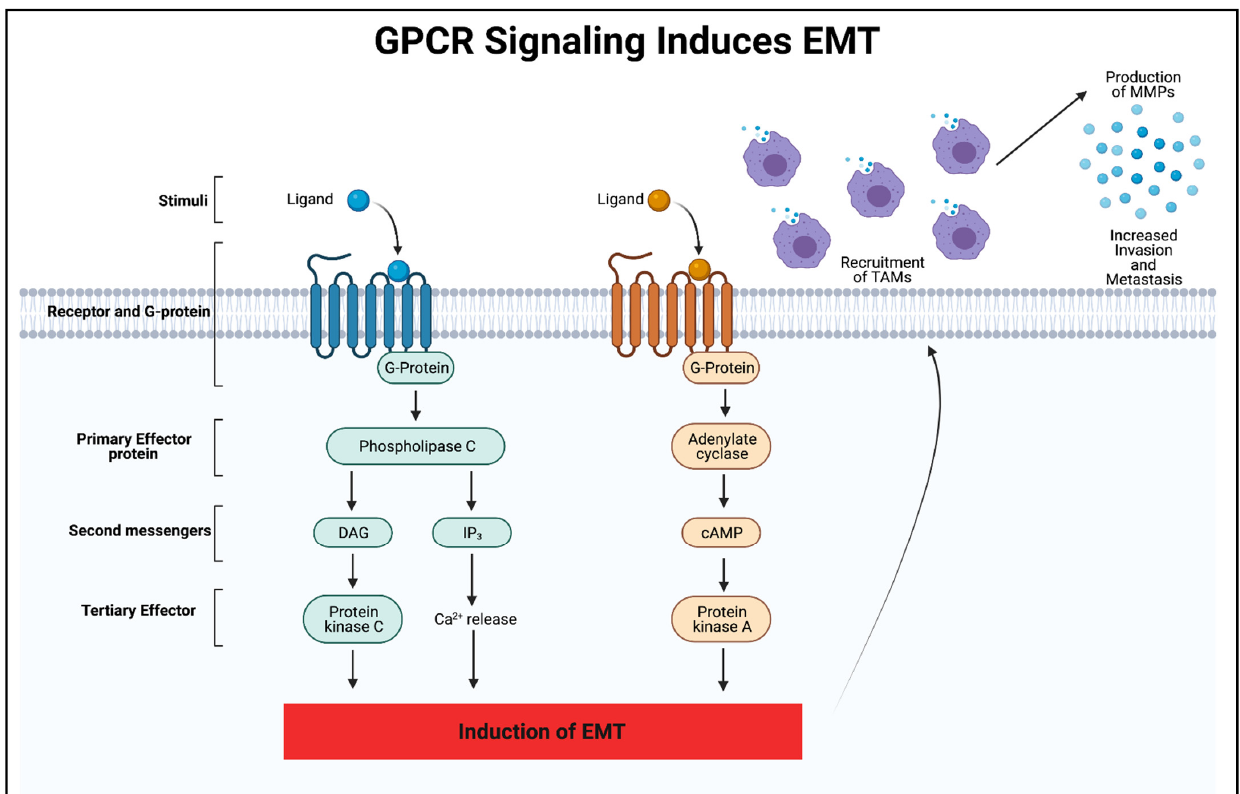
Figure 2. GPCR signaling induces EMT. This schematic illustrates the activation of a GPCR signaling pathway when bound to a ligand such as a chemokine. Both signal transduction pathways have the ability to induce EMT at a transcriptional level by activating genes such as Snail, Twist, and ZEB. GPCR signals that transcriptionally activate EMT genes are capable of recruiting TAMs to the tumor microenvironment. TAMs produce MMPs that allow these cells to invade and metastasize in the EMT process. Diacylglycerol (DAG); Inositol trisphosphate (IP 3 ); Cyclic adenosine monophosphate (cAMP).